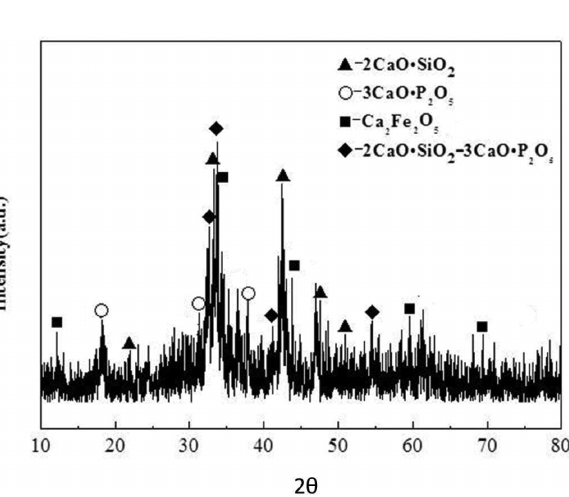
Fig. 4: XRD pattern for sample 2 quenched at 1523